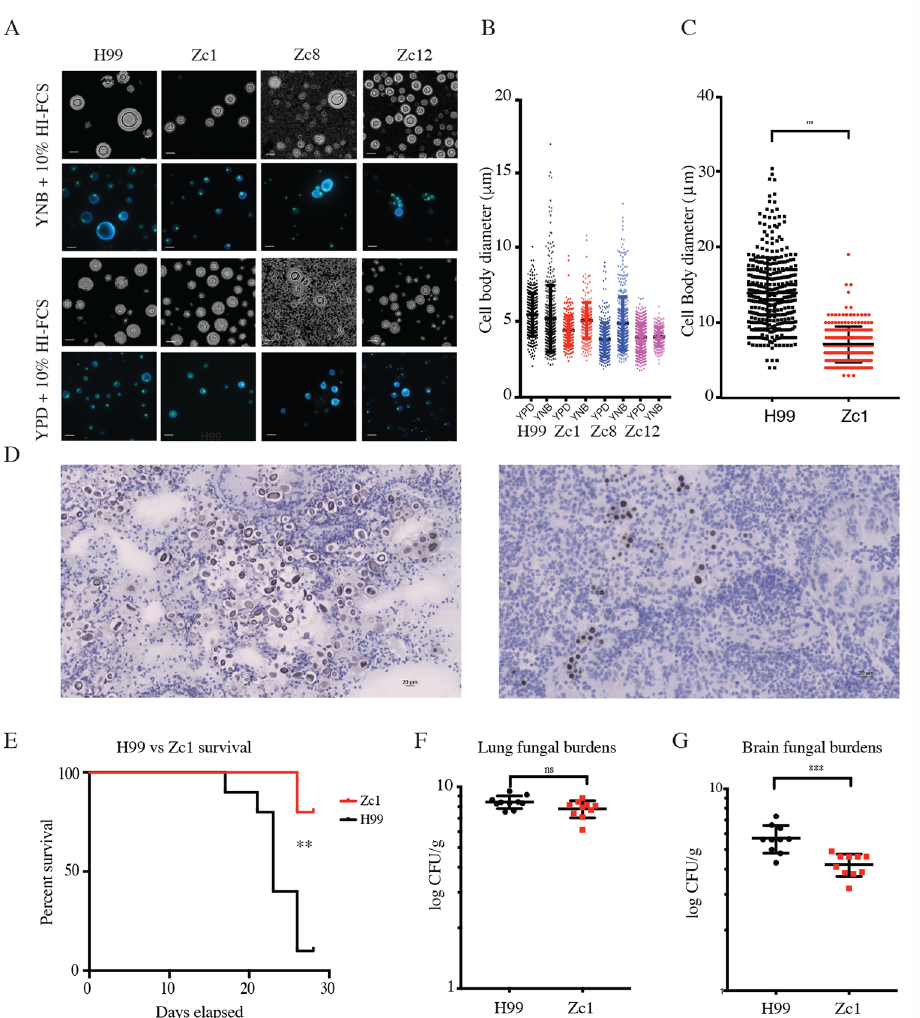
Fig 7. In vitro Titanisation predicts in vivo outcome. A,B) H99, Zc1, Zc8, and Zc12 clinical isolates were pre-cultured in either YPD or YNB and then inoculated OD 600 = 0.001 in 10% FCS (3 days, 37˚C, 5%CO 2 ). A) Representative micrographs of live cells stained with CFW and SytoxGreen or counterstained with India ink and cell size quantification are shown. B) Representative lung histology from mice infected under the indicated conditions and sacrificed on day 7. Cell size was measured for each condition (n > 500 cells for each condition). C,D) Quantification of cell size (n > 300; p = 0.001) and histology from mice infected with H99 or Zc1 for 7 days prior to C . neoformans inhalation infection. Scale bar = 20 μm. E,F,G) Balb/C mice (n = 10 per group) were infected with either Zc1 or H99 intra-nasally and followed for 28 days. E) Kaplan-Meyer survival curve (humane endpoint) (p = 0.007). CFUs for lung (F, p = 0.907) and brain (G, p < 0.0001) were measured on day of